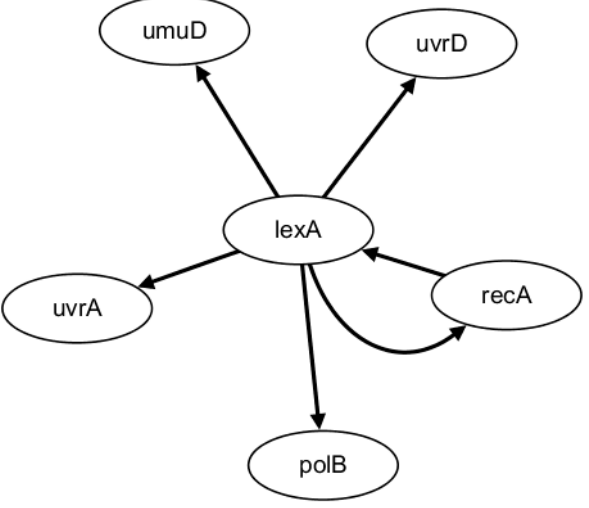
Figure 3. The inferred SOS network.